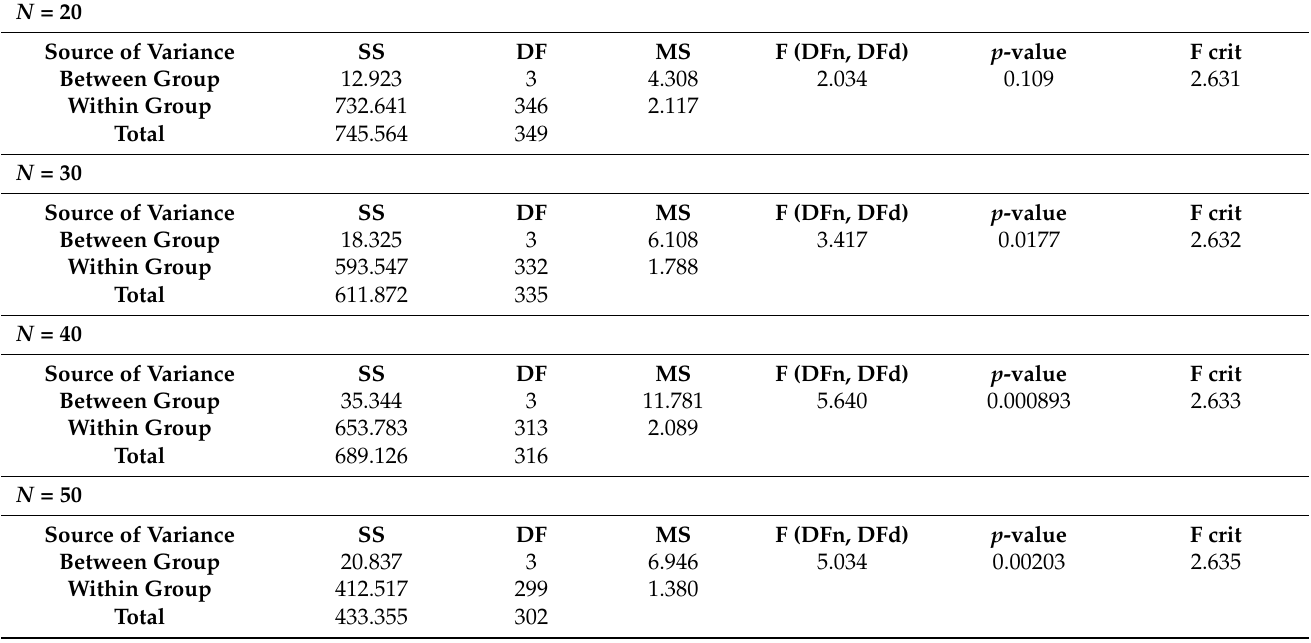
Table 3. ANOVA Test Results Based on the Performance Metrics Average